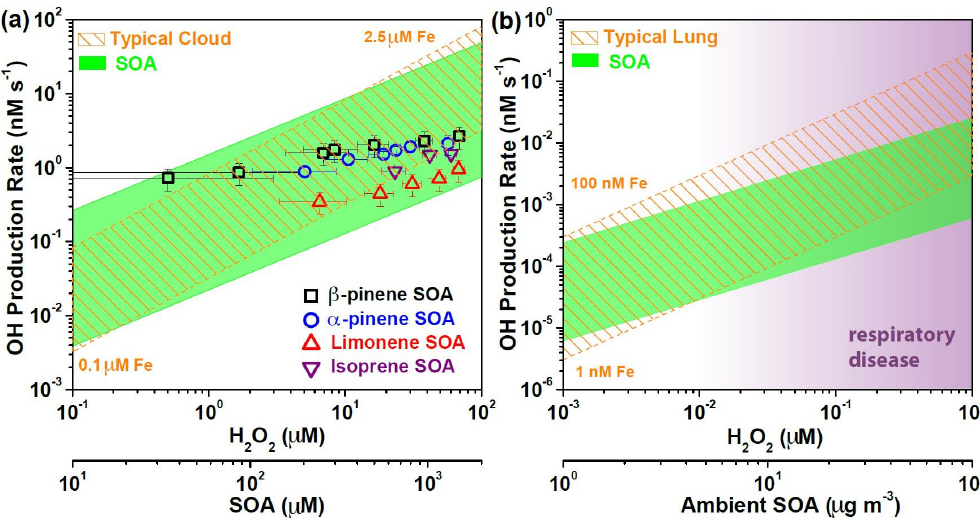
Figure 7. OH production rate in cloud droplets and lung lining fluid. (a) The OH production rate in cloud droplets by SOA decomposition compared to the classical Fenton reaction. The data points were measured in the absence of Fe 2 + for different precursors of β -pinene (black squares), α -pinene (blue circles), limonene (red upward triangles) and isoprene (purple downward triangles). The shaded green area represents the possible range in the presence of iron as a function of SOA concentration in the aqueous phase, which is based on the minimum and maximum OH radical production efficiency of SOA in Fig. 4. The dashed lines represent OH production rates due to the Fenton reaction from H 2 O 2 with typical dissolved iron concentrations (Fe 2 + :Fe 3 + = 1:1) of 0.1 and 2.5µM. (b) The OH production rate in lung lining fluid by SOA decomposition as a function of ambient SOA concentrations, and by the classical Fenton reaction as a function of H 2 O 2 concentrations with typical dissolved iron concentrations (Fe 2 + :Fe 3 + = 1:1) of 100 and 1nM. The purple shaded area represents patients with respiratory disease exhibiting high H 2 O 2 concentrations in the bronchoalveolar lavage (Corradi et al., 2008).